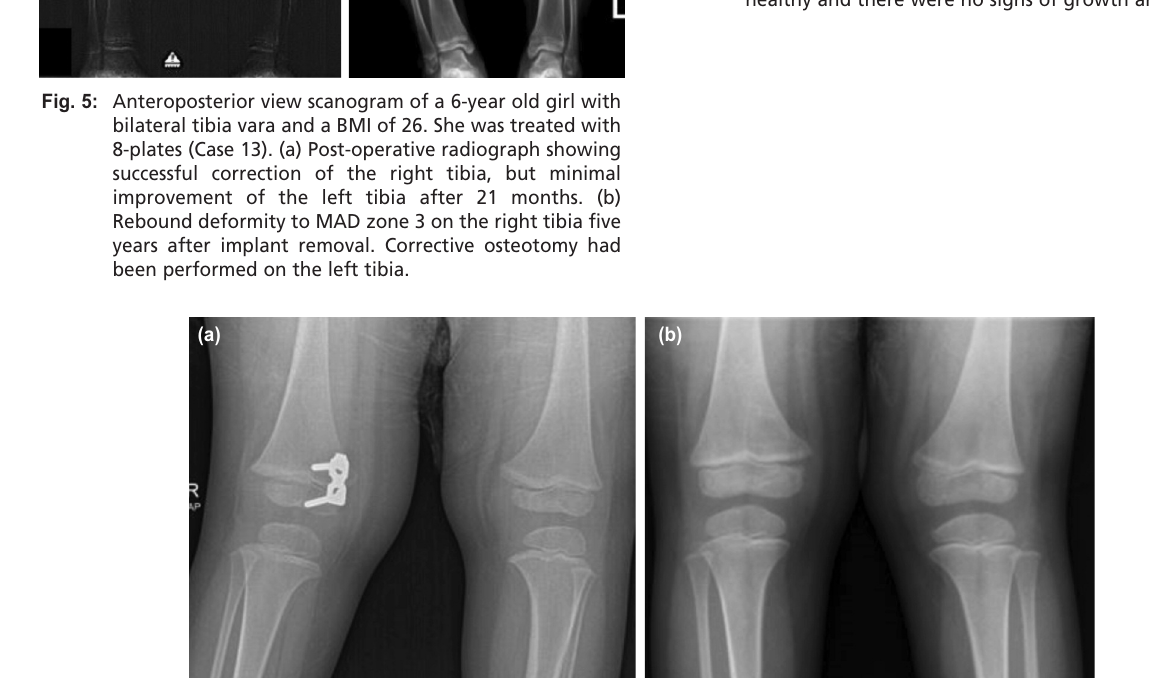
Knee radiographs of a 6-year-old girl who had bilateral Fig. 6: 8-plates inserted for tibia vara at the age of 3. The plates were removed after 27 and 38 months for the right and left tibia, respectively. The lateral growth plates appear healthy and there were no signs of growth